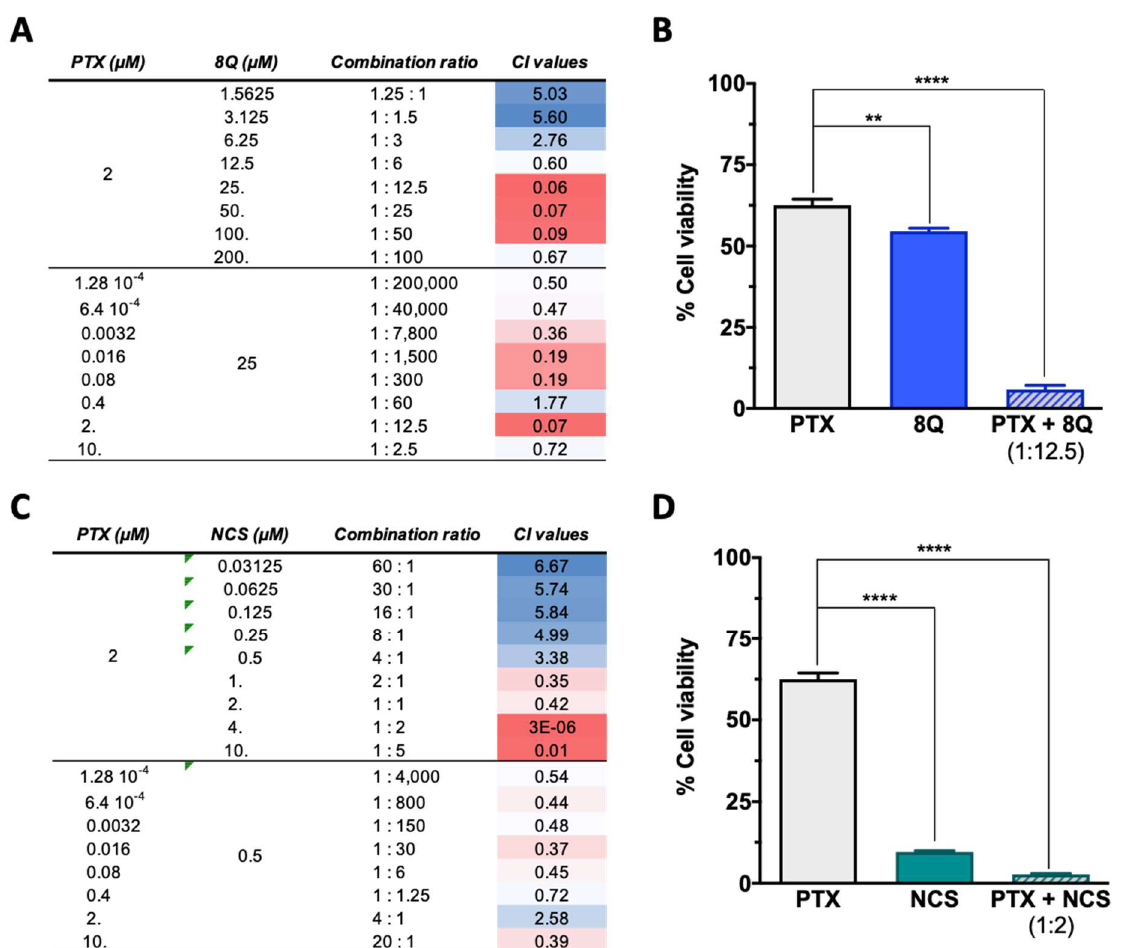
Figure 4. Effect of the combination of 8Q and NCS with PTX on the cell viability of MDA-MB-231 cells. ( A ) Combination index (CI) of different PTX to 8Q drug ratios, shown as heat maps (CI > 1 indicating antagonism in blue, CI < 1 showing synergism in red). Studies were done fixing the PTX concentration first at its IC 50 value (2 µM) and changing the 8Q concentration (top values), fixing the 8Q concentration at its IC 50 value (25 µM) and varying the PTX concentration (bottom values). ( B ) Viability of MDA-MB-231 cells treated with PTX, 8Q or the 1:12.5 PTX:8Q ratio. ( C ) CI of different PTX to NCS ratios, again fixing first the PTX at its IC 50 value (2 µM) and changing the NCS concentration (IC 50 value 0.5 µM) and vice versa (lower part of the table). ( D ) Viability of MDA-MB-231 cells treated with PTX, NCS or the 1:2 PTX:NCS ratio. Data are represented as the mean ± SEM of three independent experiments (** p < 0.01, **** p < 0.0001).